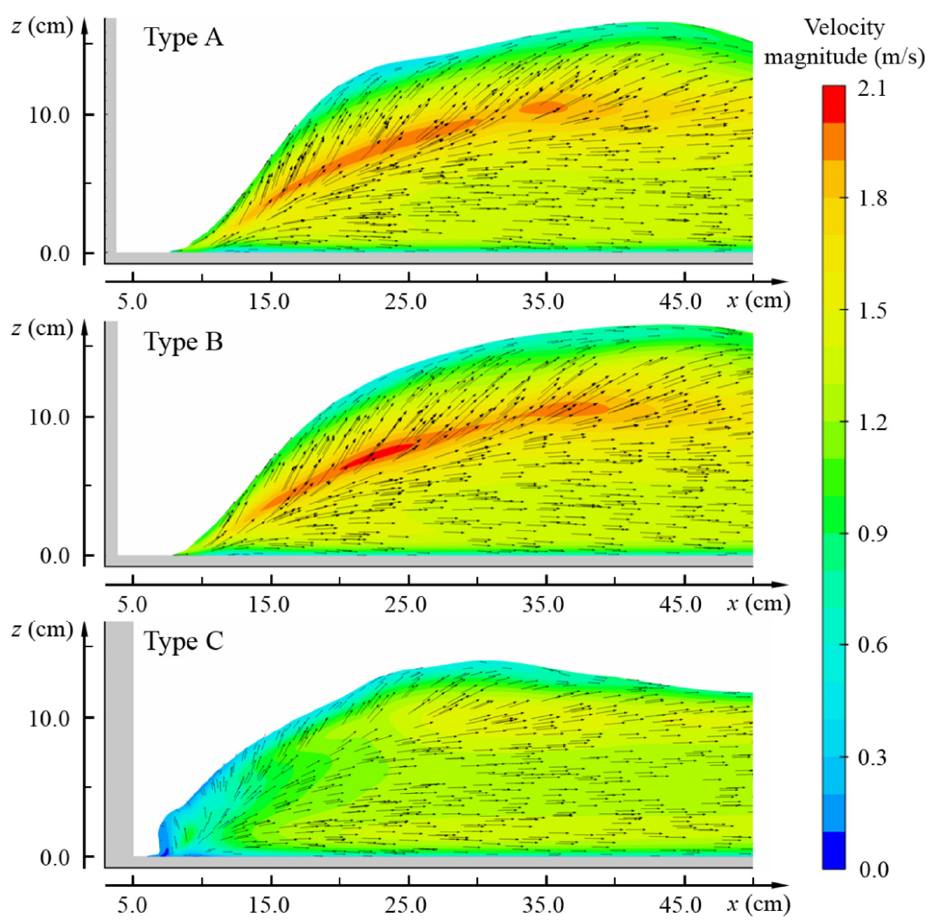
Figure 8. Velocity distribution near the sidewall ( y = − 9.3 cm). The vectors are generated using the same density and scale for the three types of deflectors.